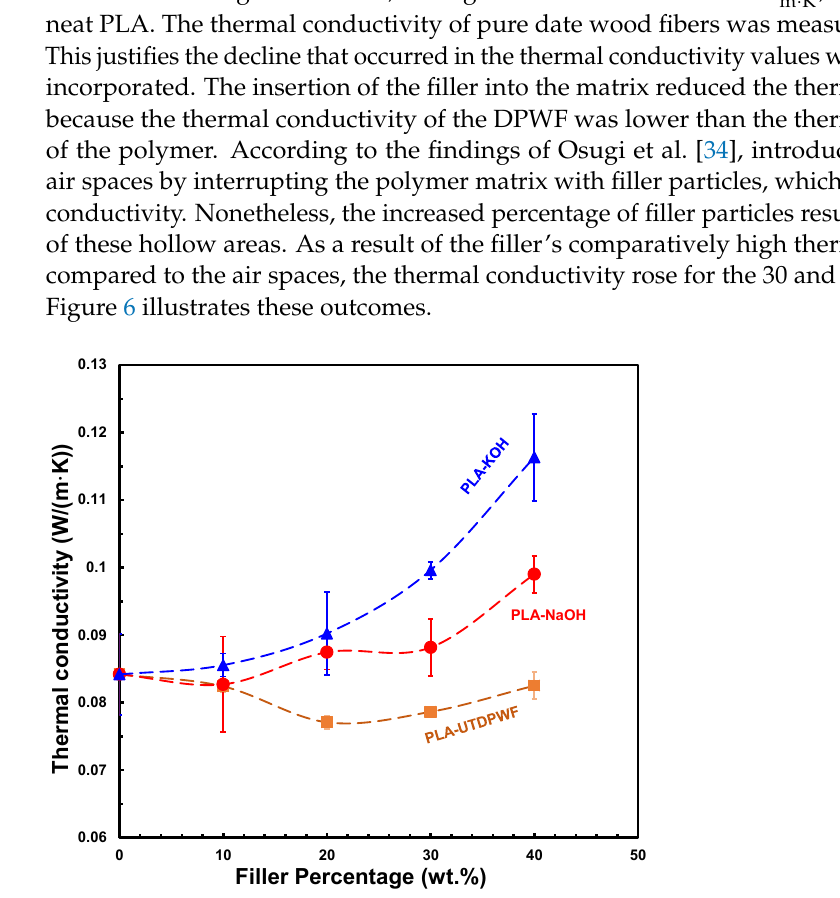
Figure 6. Thermal conductivity of PLA-UTDPWF, PLA-NaOH, and PLA-KOH at 25 °C.